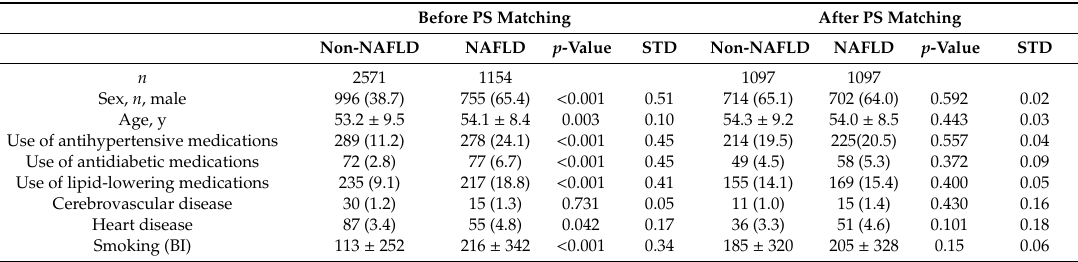
Table 1. Baseline characteristics before and after propensity score (PS)